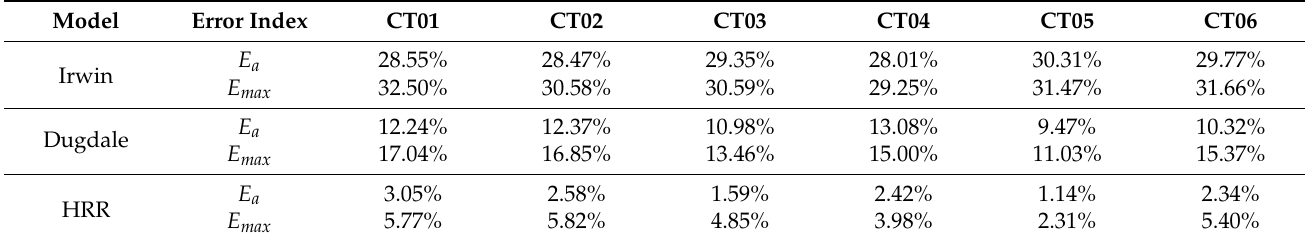
Table 4. Error statistics of numerical model prediction